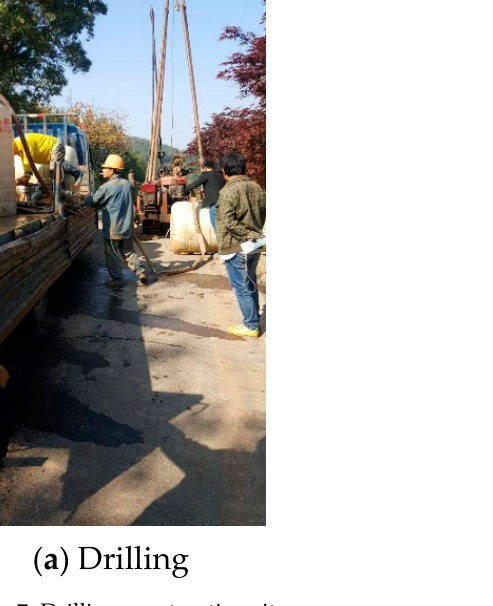
Figure 7. Drilling construction site.